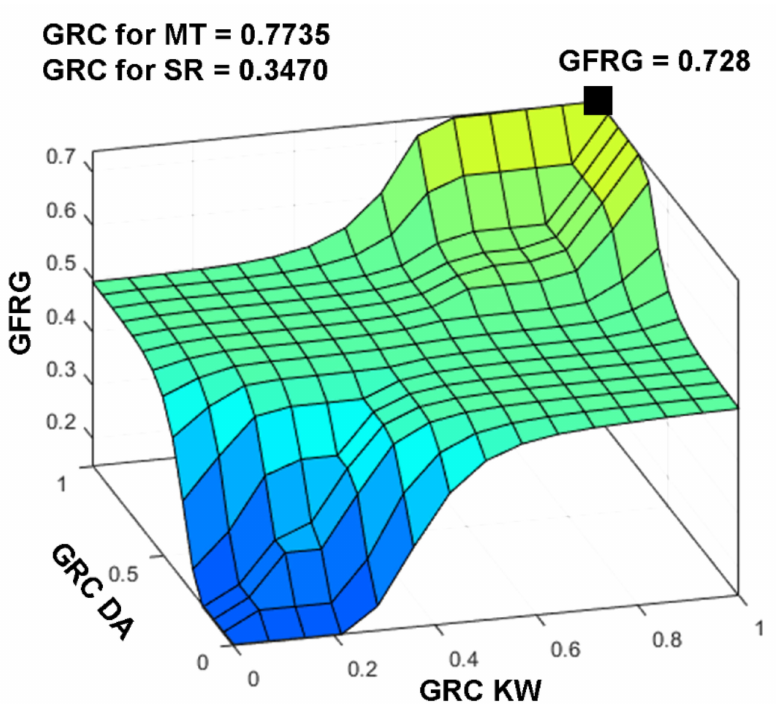
Figure 7. 3D surface plot of GFRG.